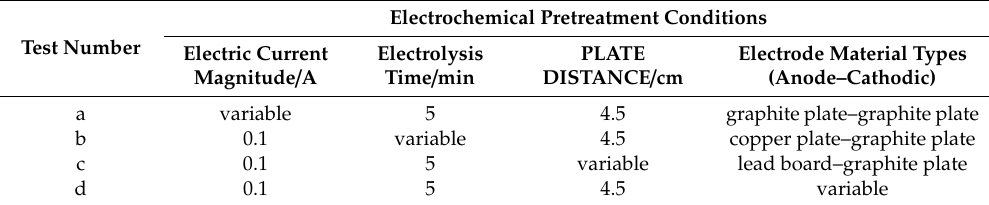
Table 2. Electrochemical pretreatment conditions.